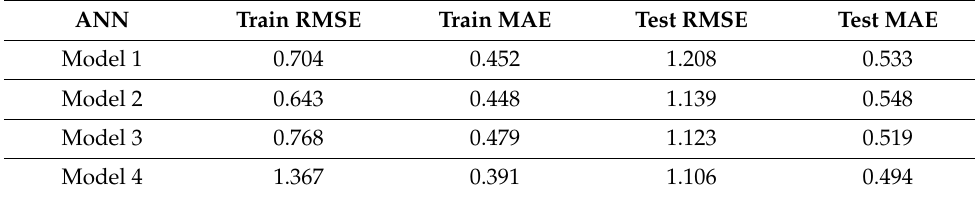
Table 11. Train and test RMSE and MAE for all ANN models.